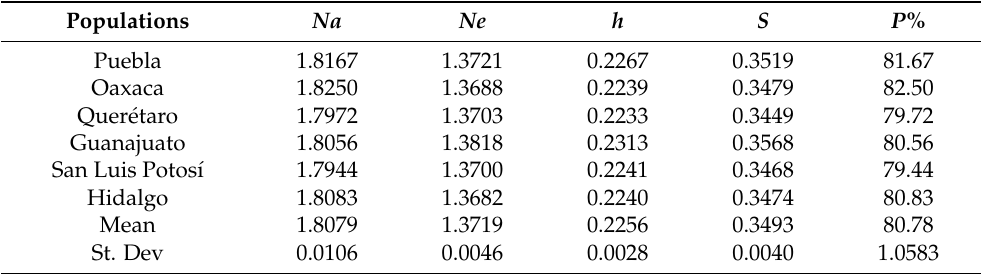
Table 1. Statistics for 120 individuals of Brickellia veronicifolia with 12 iPBS primers.